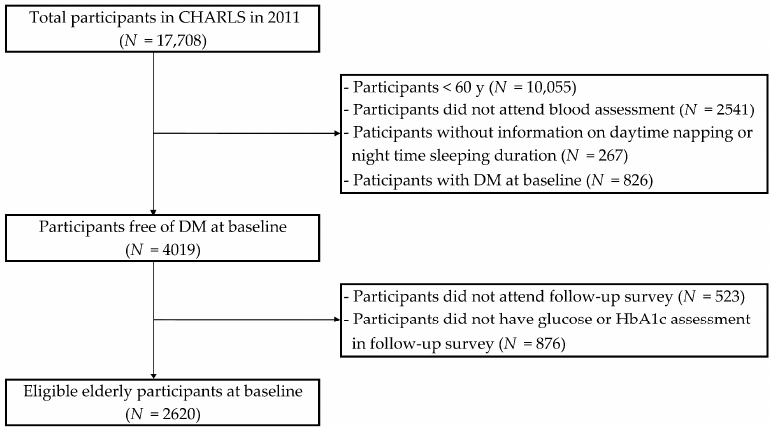
Figure 1. Study flowchart of participant